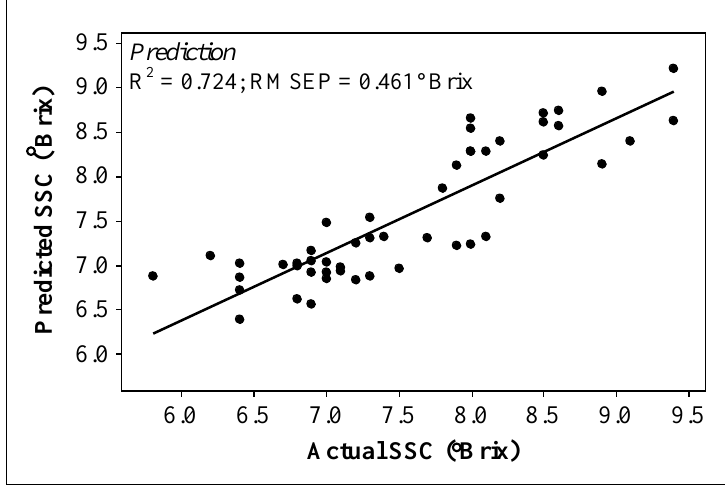
Figure 5. Prediction of carambola SSC through interactance spectral linearisation.